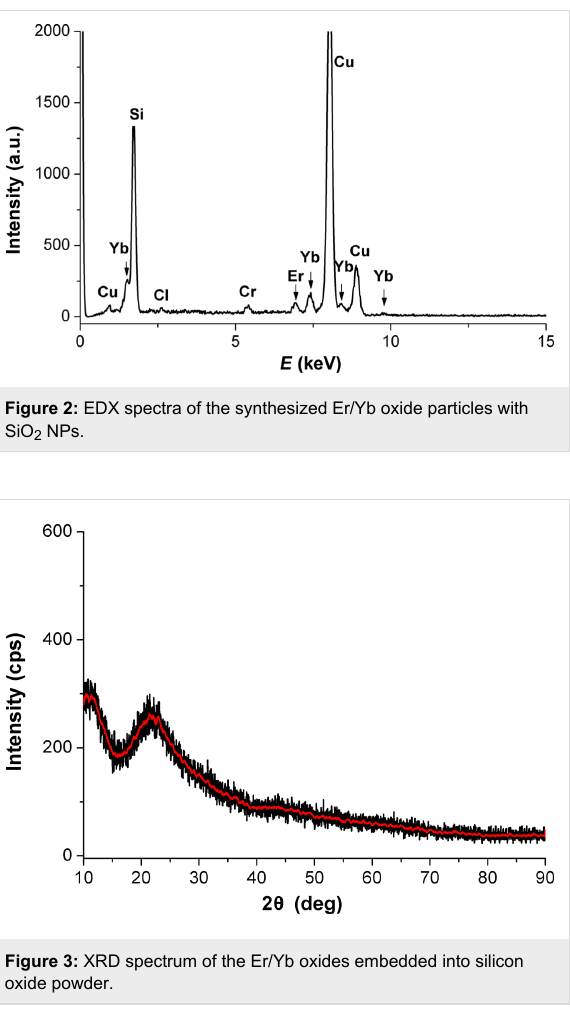
Figure 3: XRD spectrum of the Er/Yb oxides embedded into silicon oxide